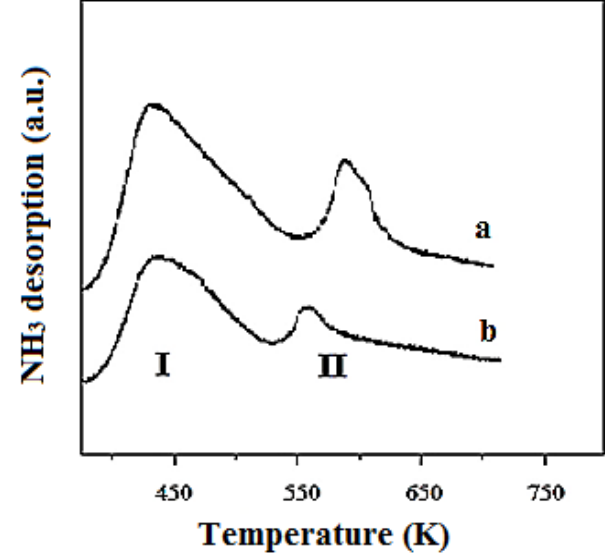
Fig. 7 . NH -TPD profile a) Al-B catalyst, b) Al-A 3